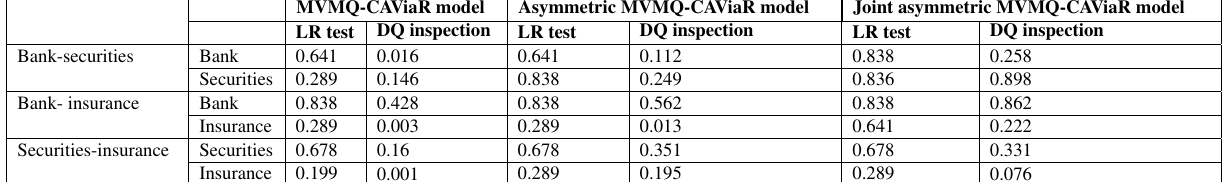
Table 5 Backtest results of the model MVMQ-CAViaR